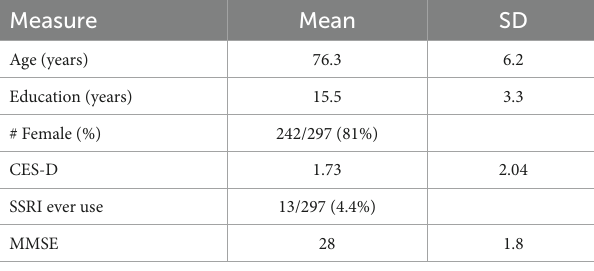
TABLE 1 Sample characteristics ( N = 297). TABLE 2 List of most probable connections passing through the white matter clusters showing significant associations of depressive symptoms and trace of the diffusion tensor adjusting for age, education, sex, scanner, total volume of WMHs normalized by intracranial volume, and the presence of WMH at the voxel level as seen in Figure 2.